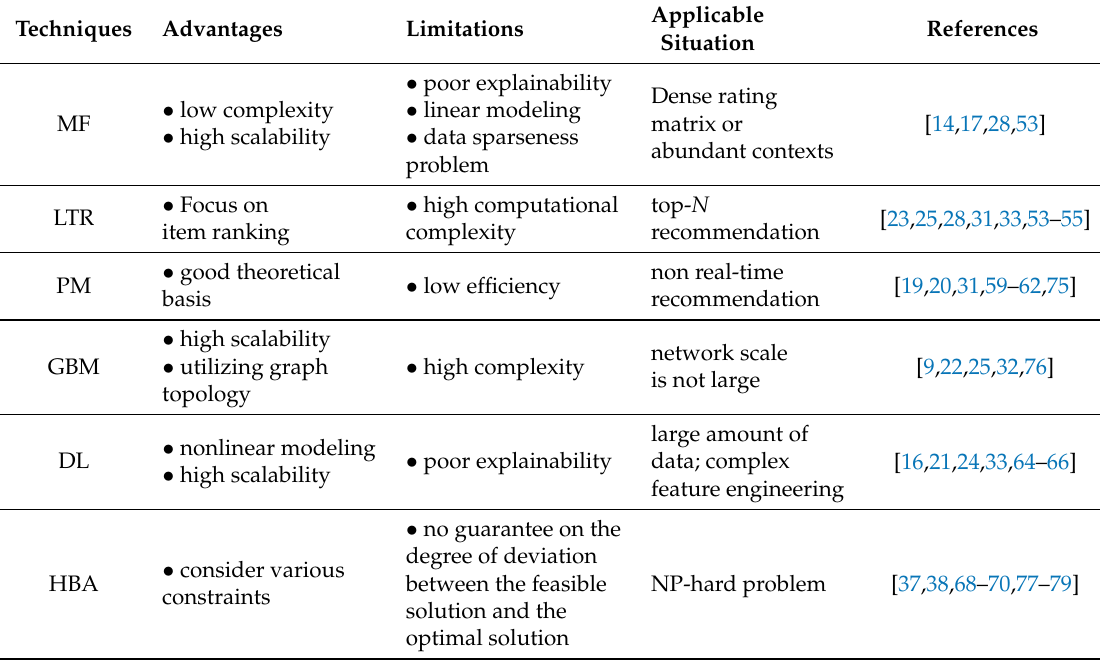
Table 2. Overview of techniques used about CARS in